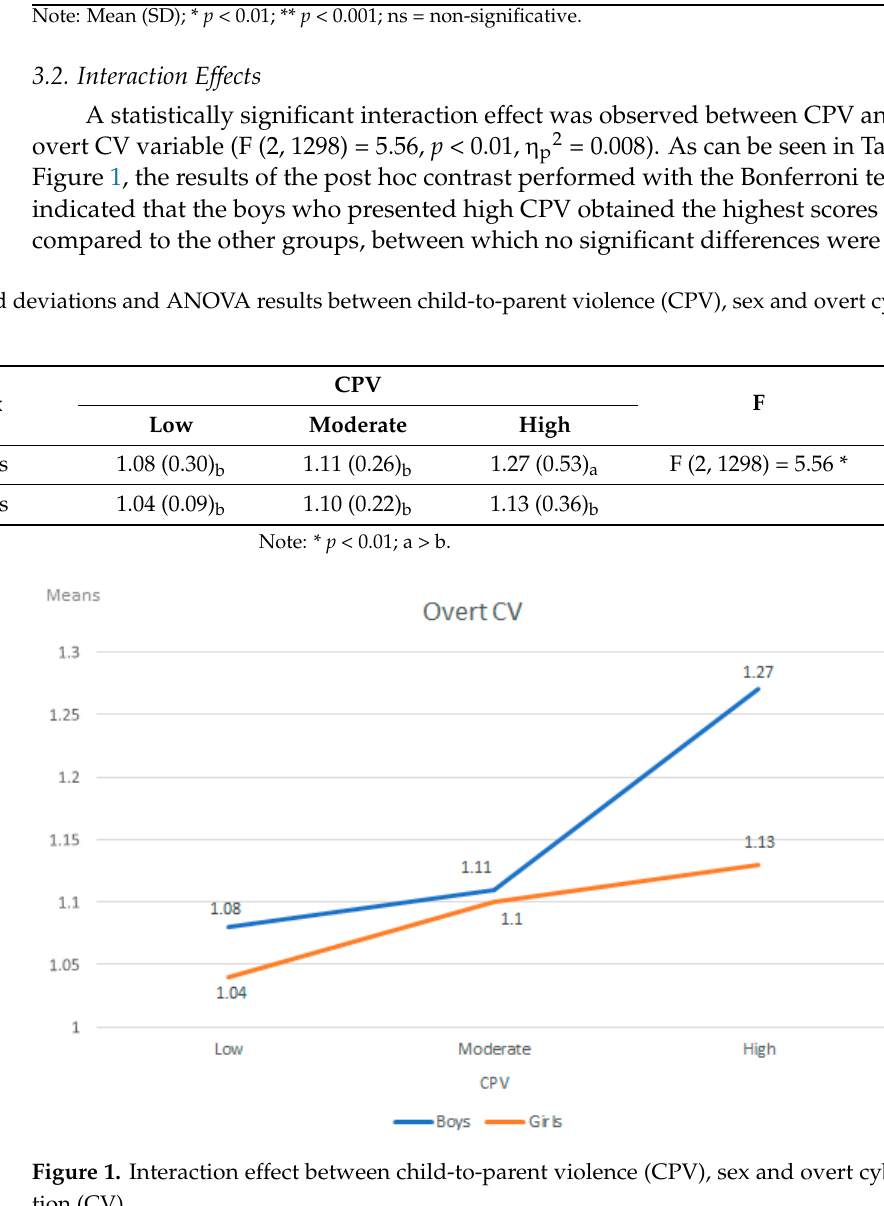
Figure 1. Interaction effect between child-to-parent violence (CPV), sex and overt cybervictimization